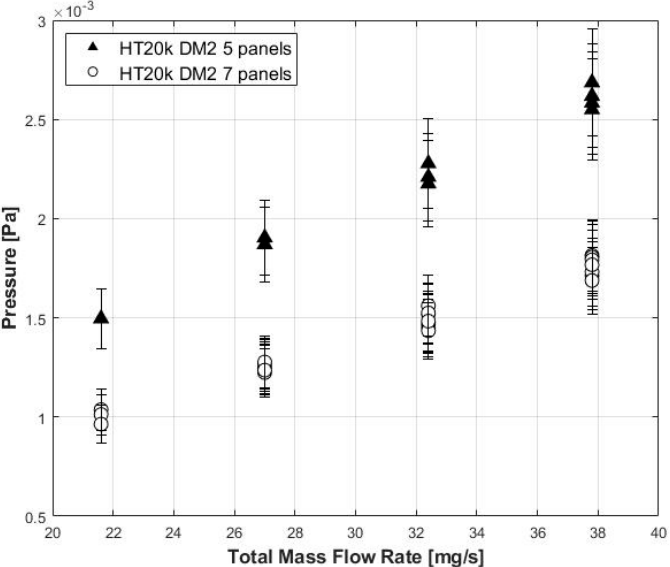
Figure 7. Comparison with the measured pressure with 5 and 7 cold panels as a function of the mass flow total mass flow rate.